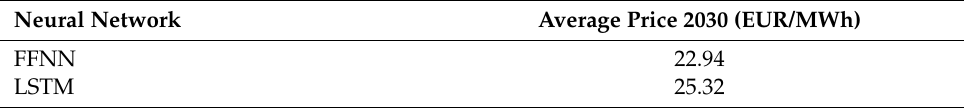
Table 10. Forecasted annual average electricity price for 2030 in MIBEL.